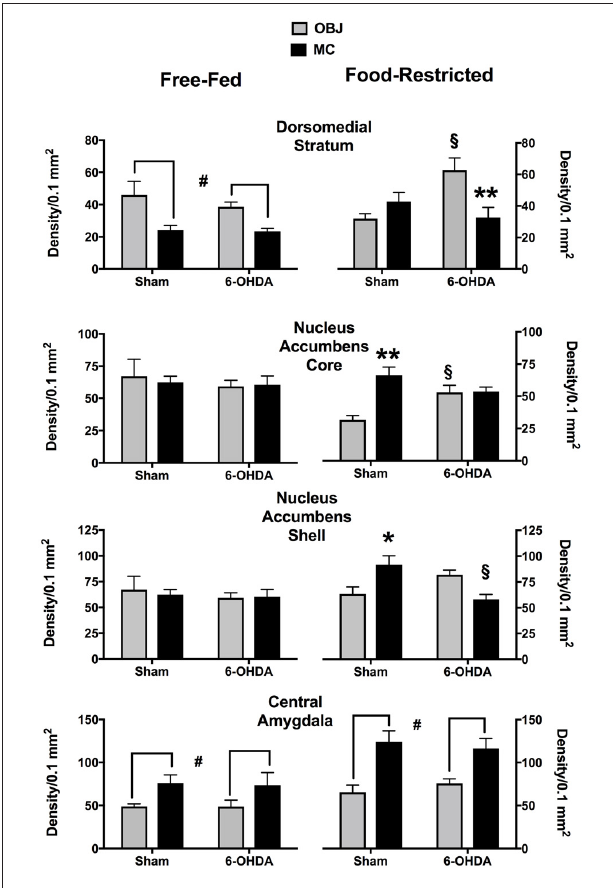
FIGURE 2 | C-fos expression (mean density ± SEM) induced by the first exploration of a small piece of plastic (OBJ) or a piece of milk chocolate (MC) in different experimental conditions. # Main effect of the novel stimulus (OBJ vs. MC; see text for details). ∗ , ∗∗ p < 0.05, p < 0.01 vs. OBJ (Tukey correction for multiple comparisons). § p < 0.05 vs. Sham (Tukey correction for multiple comparisons).